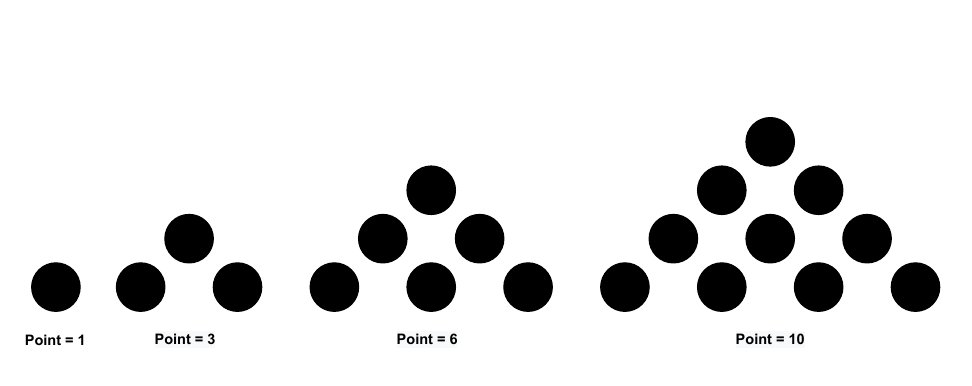
Figure 3. Examples of the triangular